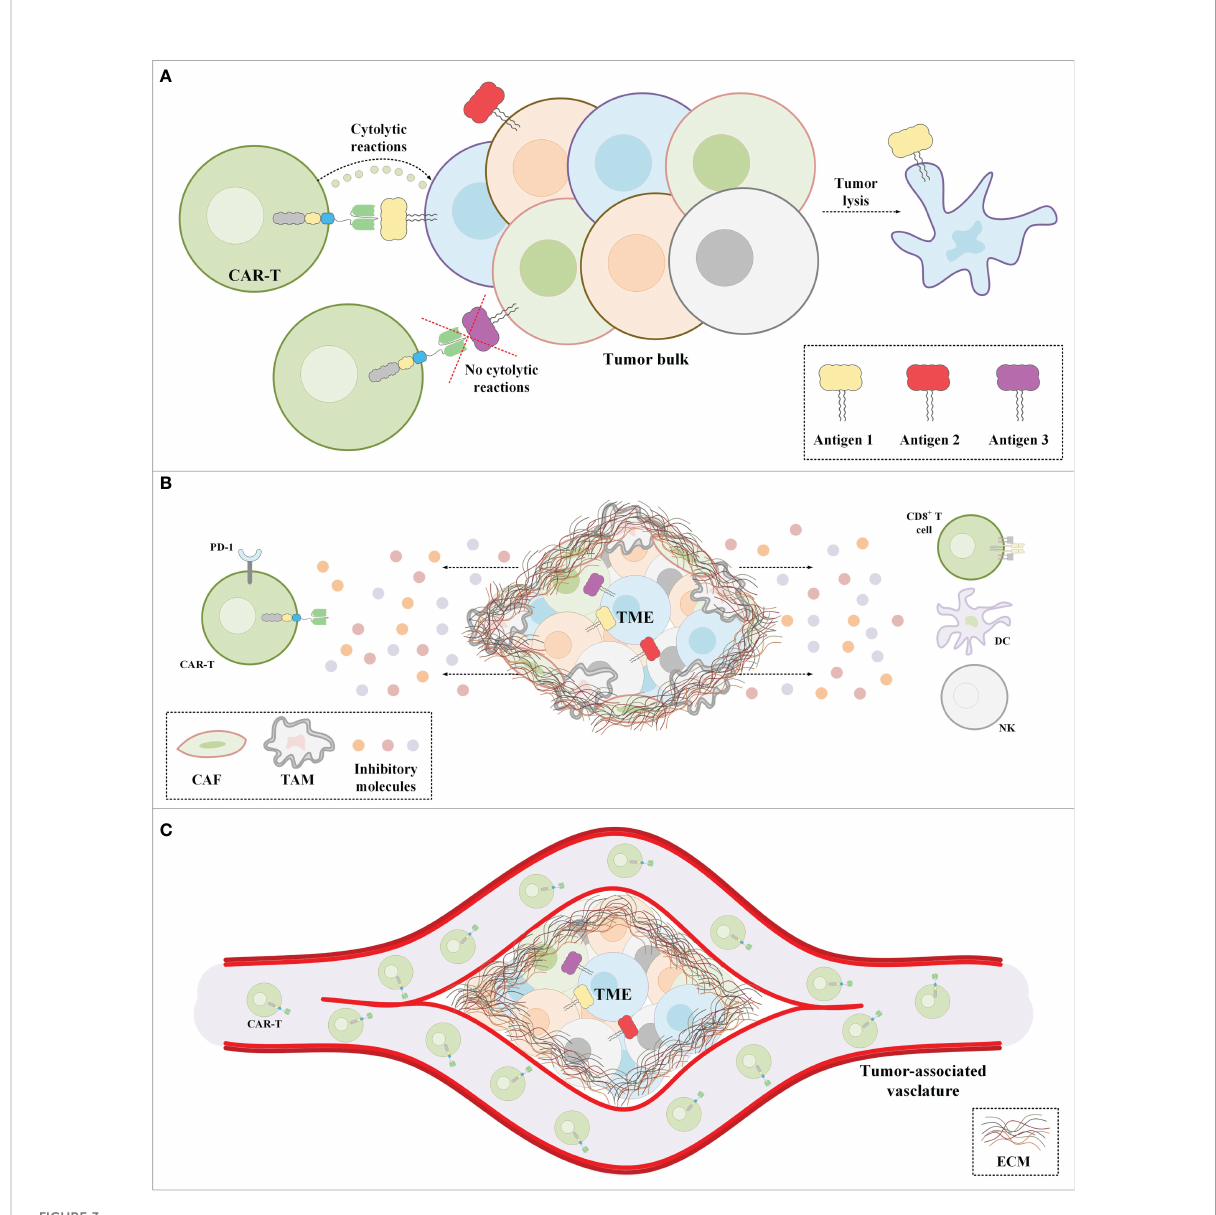
FIGURE 3 The major impediments of CAR-T therapy in solid tumors. (A) CAR-Ts encounter tumor cells only a proportion of which express the CAR- redirected target antigen. Moreover, in a population of tumor cells, there might be malignant cells not expressing any known target antigens. (B) The immunosuppressive nature of the TME suppresses CAR-T antitumor activity. (C) The extracellular matrix of solid tumors is the most important physical barrier between the tumor cells and CAR-Ts in CAR-T therapy of solid tumors. Cancer-associated fi broblasts are among the mediators responsible for the formation of the stroma extracellular matrix. CAF, cancer-associated fi broblast; CAR-T, chimeric antigen receptor T-cell; DC, dendritic cell; EMC, extracellular matrix; NK, natural killer cell; PD-1, programmed death-1; TAM, tumor-associated macrophage; TME, tumor